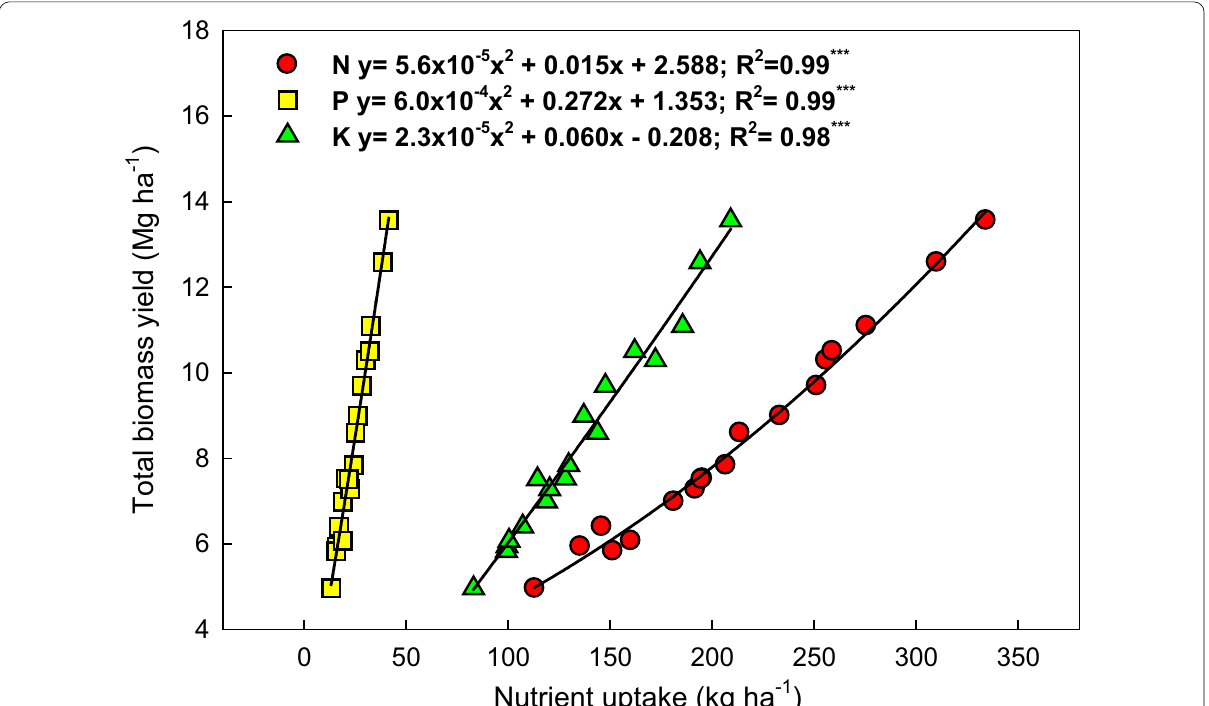
Fig. 5 Relationship of nutrient uptake (N, P, and K) and total biomass yield (stover